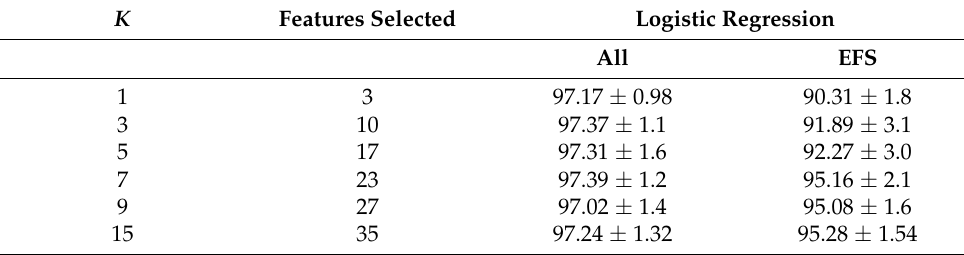
Table 2. Accuracy results—logistic regression.